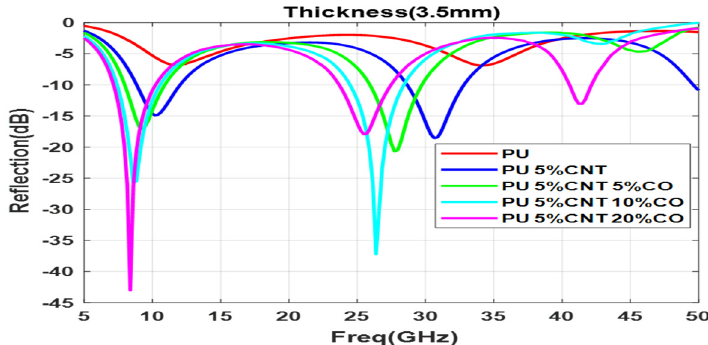
Figure 13. Reflection loss for different concentrations of Co at 3.5 mm thickness.